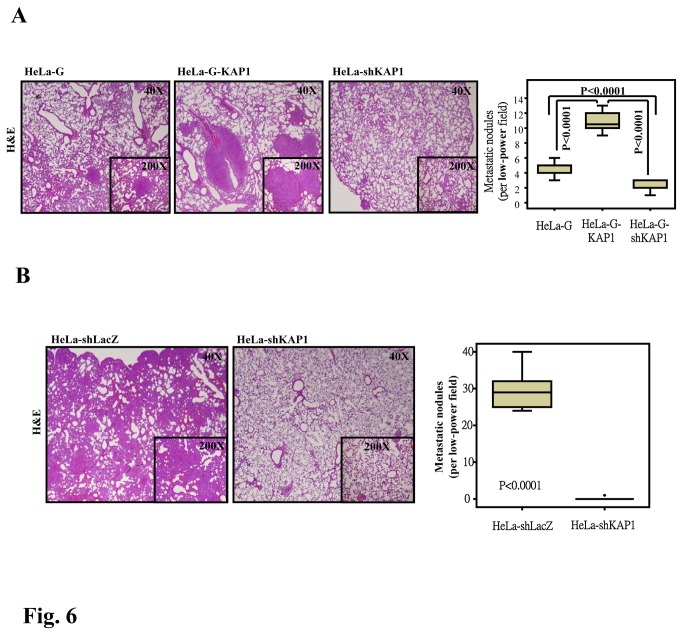
KAP1 enhances cancer cell metastasis in vivo.Hematoxylin and eosin (H and E) staining of HeLa cell-derived lung metastasis after 4-6 weeks is shown. Six NOD-SCID mice were tail-vein (A) or subcutaneously (B) injected with parental, KAP1-expressing (G-KAP1) or lentiviral shRNA against KAP1 (shKAP1)-expressing HeLa cells. Representative images of H&E staining sections from metastatic tumor lung tissues are displayed. Magnification: 40 X and 200 X. Analysis of both groups indicated that KAP1 expression significantly affects the metastatic potential of HeLa cells.